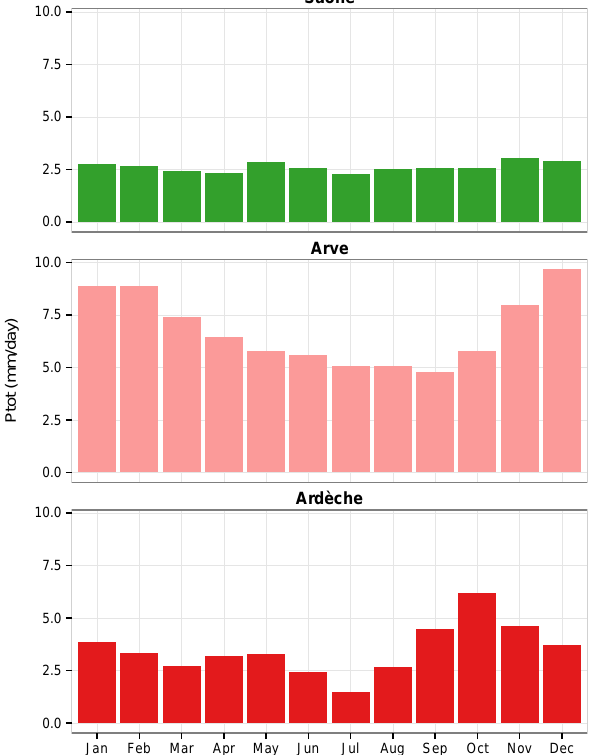
Fig. 2. Monthly mean precipitation, 1 August 1958–31 July 2002, from the Safran data for the three case study zones Saône, Arve and